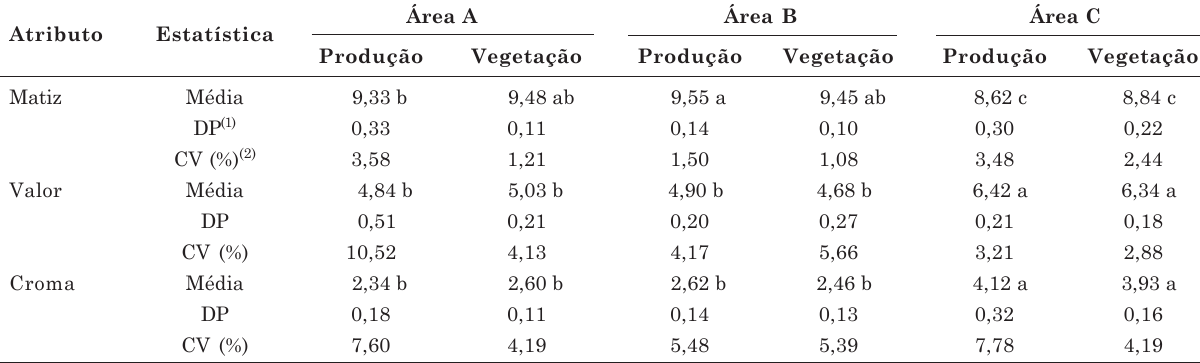
Quadro 3. Valores médios dos constituintes da cor dos solos estudados na profundidade de 0,0-0,2